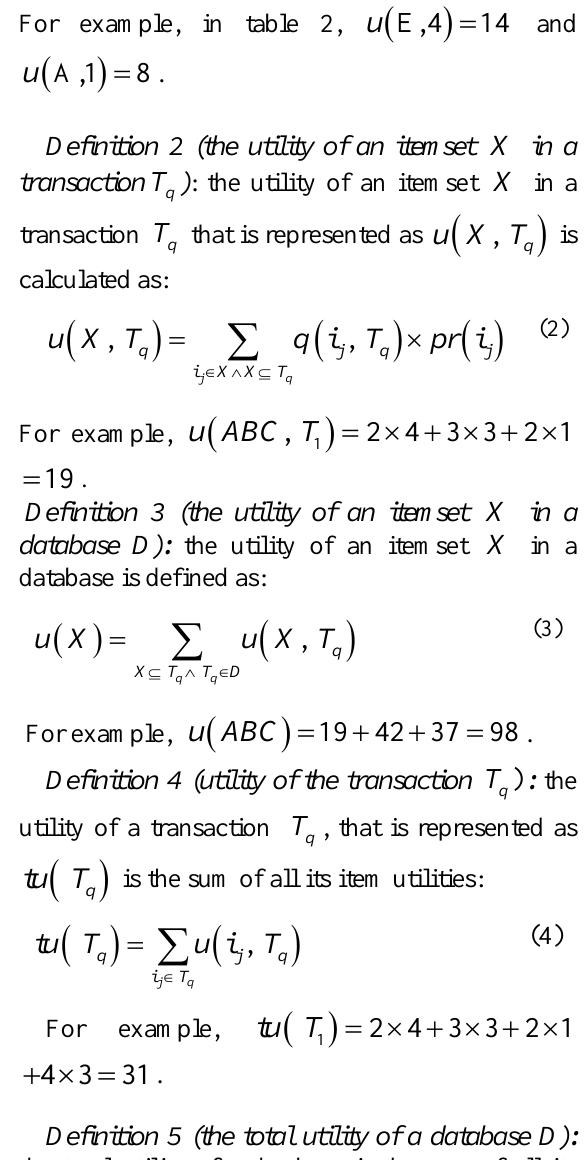
Table 3. External